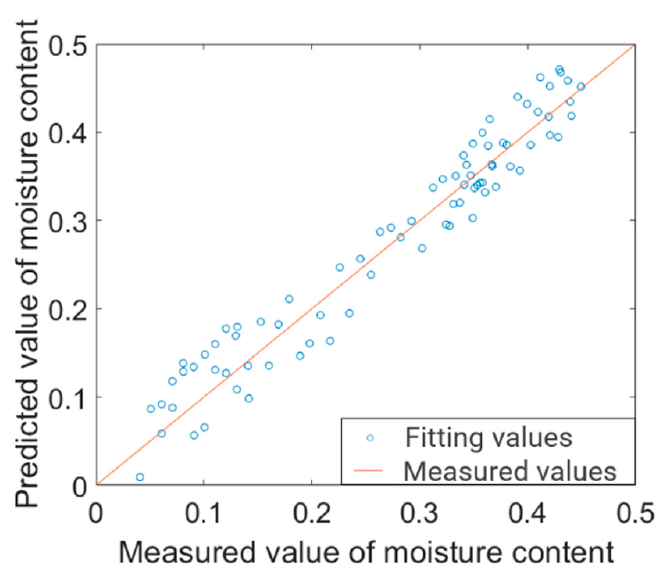
Figure 10. Fitting curves of specimens with saturation.